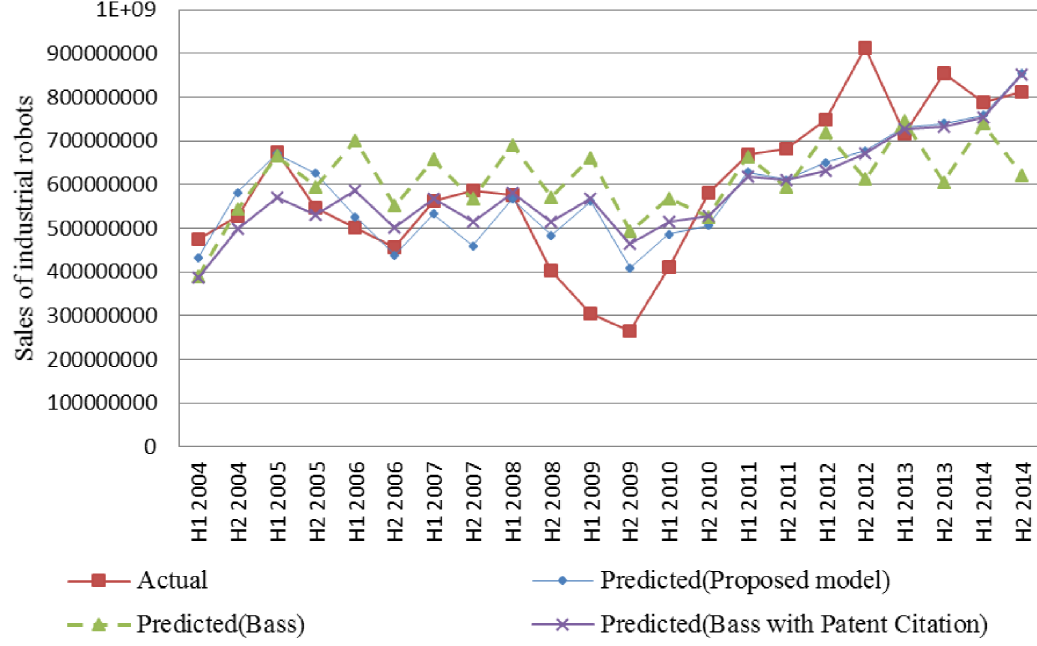
Fig 2. Comparison of actual and estimated sales of industrial